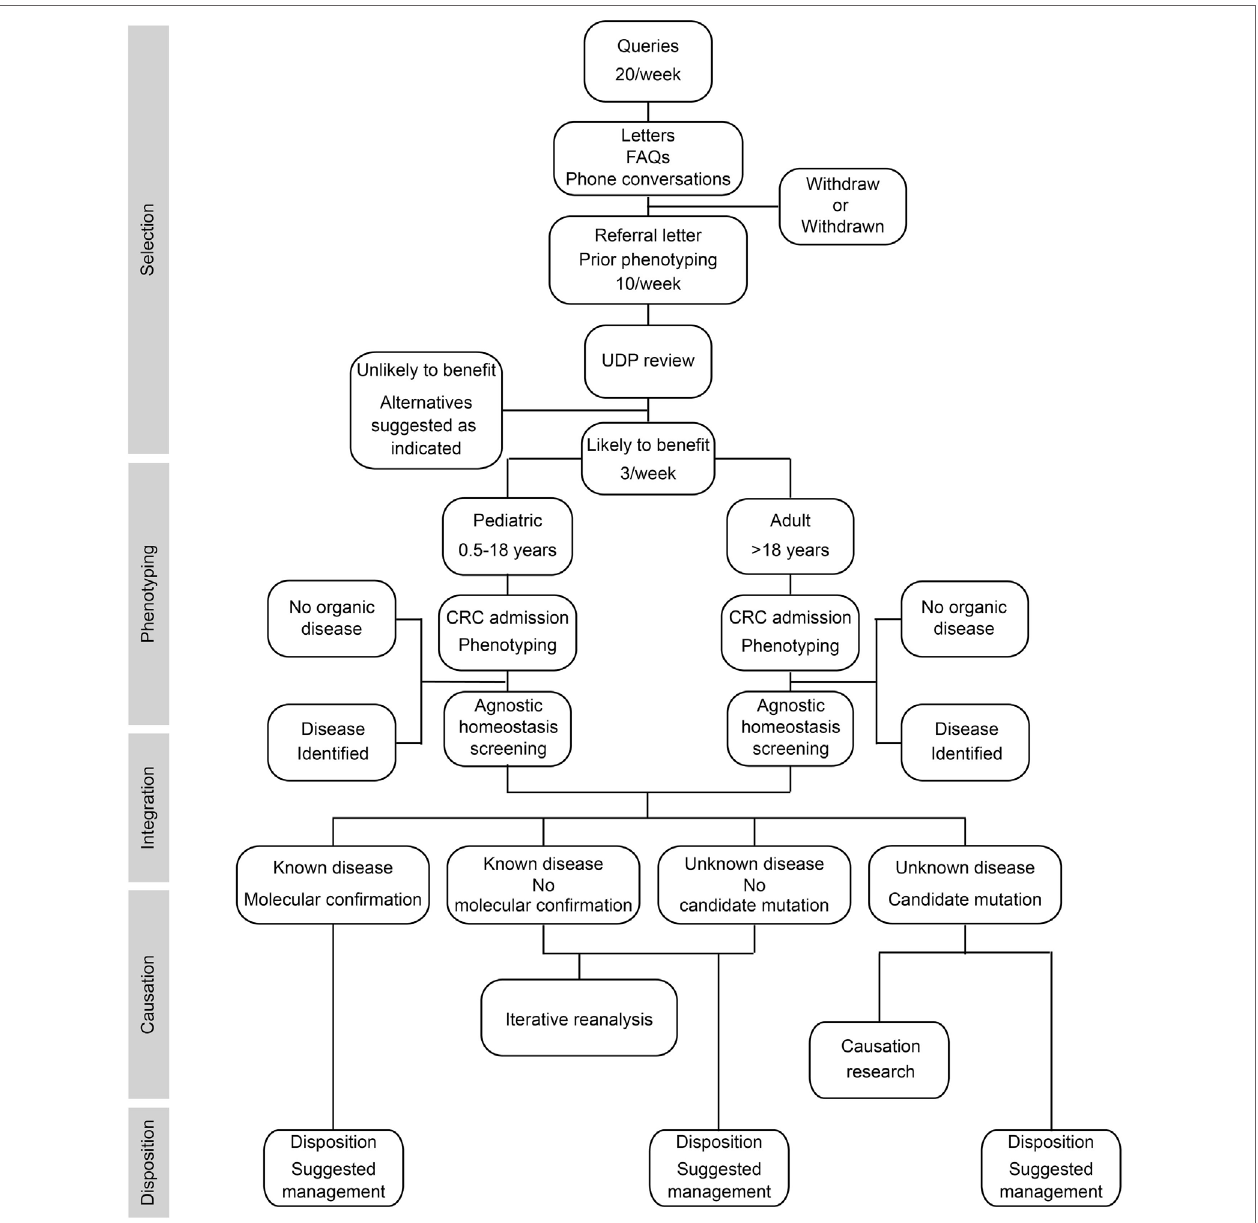
FIGURe 1 | Flow diagram showing the process by which patients are accepted into and evaluated for a diagnosis within the National Institutes of health (NIh) Undiagnosed diseases Program (UdP) . The process is divided into five major components listed along the left side. The initial component is patient selection. This is followed by patient admission to the NIH clinical research center (CRC) for phenotyping and, when appropriate, agnostic screening for disturbances of evolutionary, developmental, and biochemical homeostases. These data are then integrated computationally and through discussion to determine if there is a known medical diagnosis. Patients with a diagnosis are given disposition recommendations based on that diagnosis. For those without a diagnosis and without a candidate cause, their data are queued for iterative reanalysis, and they and their referring physician are given disposition recommendations based on what was learned. For those without a diagnosis and with a candidate cause, their data are subjected, as resources allow, to research studies to evaluate the potential causality, and they and their referring physician are given disposition recommendations based on what was